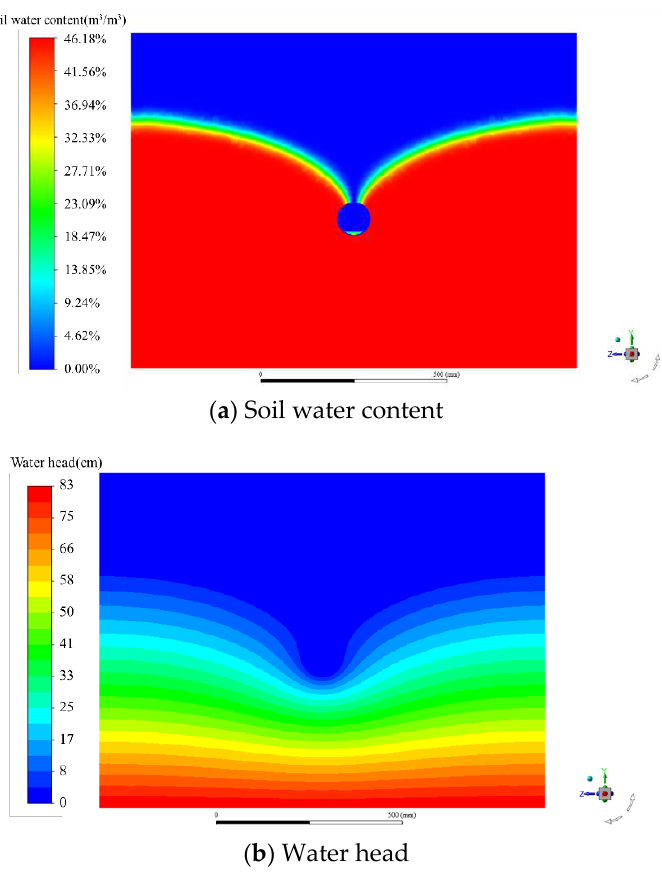
Figure 9. Distribution profiles.